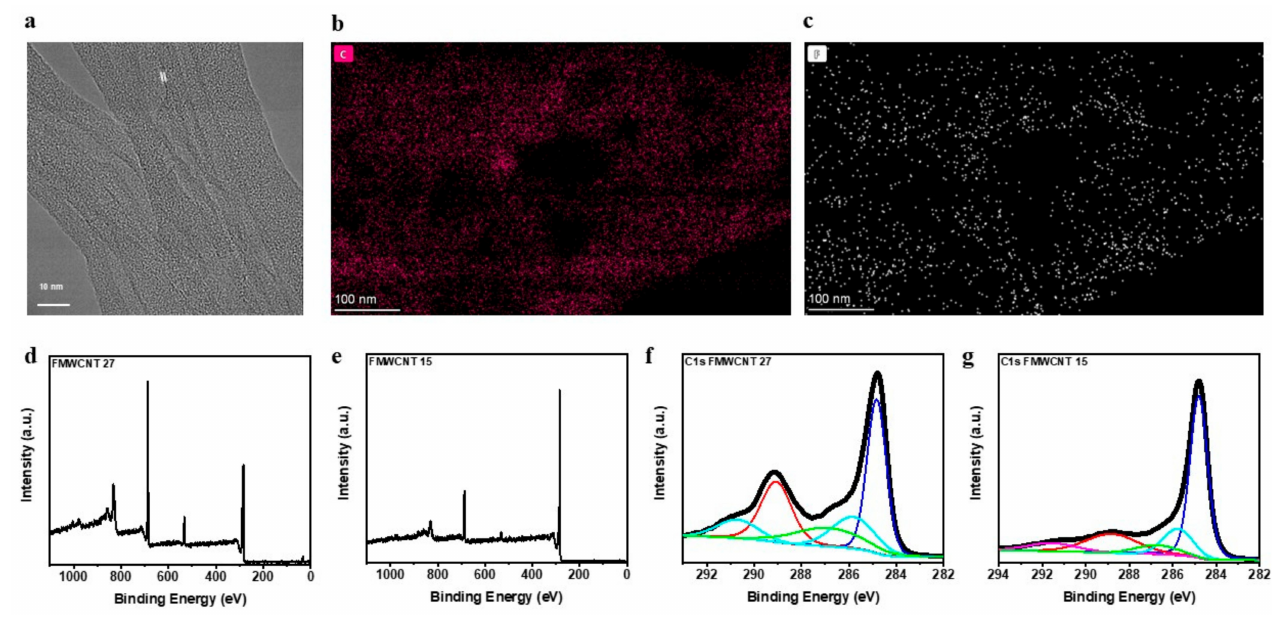
Figure 1. ( a ) High resolution transmission electron microscopic image of FMWCNT-27 sample. TEM- EDS elemental mapping of ( b ) carbon and ( c ) fluorine. X-ray photoelectron spectroscopic survey scans of ( d ) FMWCNT-27, ( e ) FMWCNT-15, and the deconvoluted C1s spectra of ( f ) FMWCNT-27 and ( g )